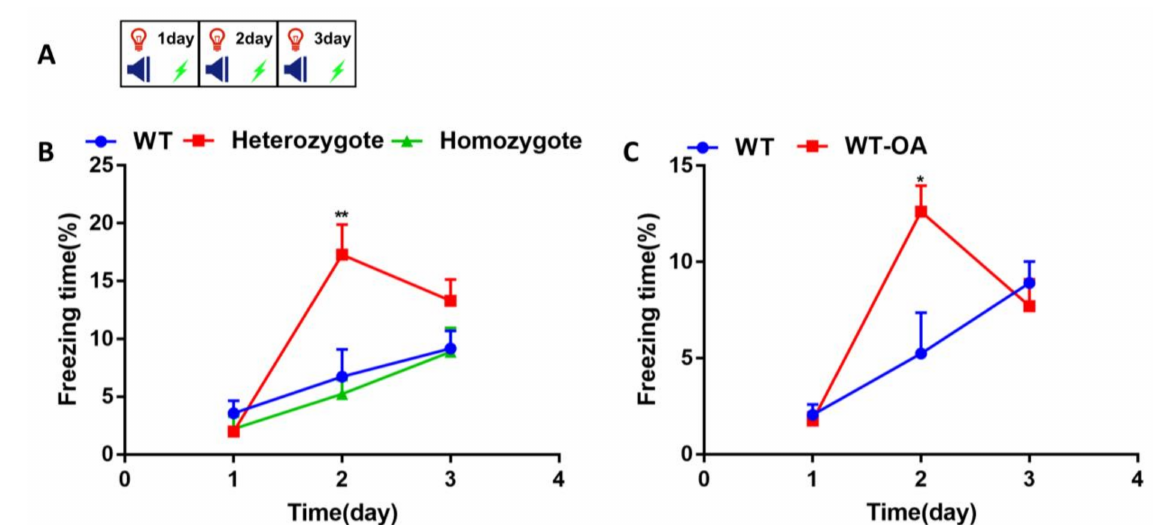
Figure 2. Enhanced fear conditioning memory in BChE heterozygous mice and mice administered ( R )-bambuterol orally of 4-month-old. ( A ) Experimental design for the fear conditioning training. The freezing time was measured during 180 s of adaptation and 2 cycles of CS + US. ( B ) The percentage of freezing time of wild-type (WT), BChE heterozygous, and BChE KO mice. ( C ) The percentage of freezing time of ( R )-bambuterol administered through oral (WT-OA). n = 7–8 mice per group. Data were represented as mean ± SEM. * p < 0.05; ** p < 0.01; vs. WT group, one-way ANOVA followed by Tukey’s post hoc test (for B ) and unpaired t test (for C ).